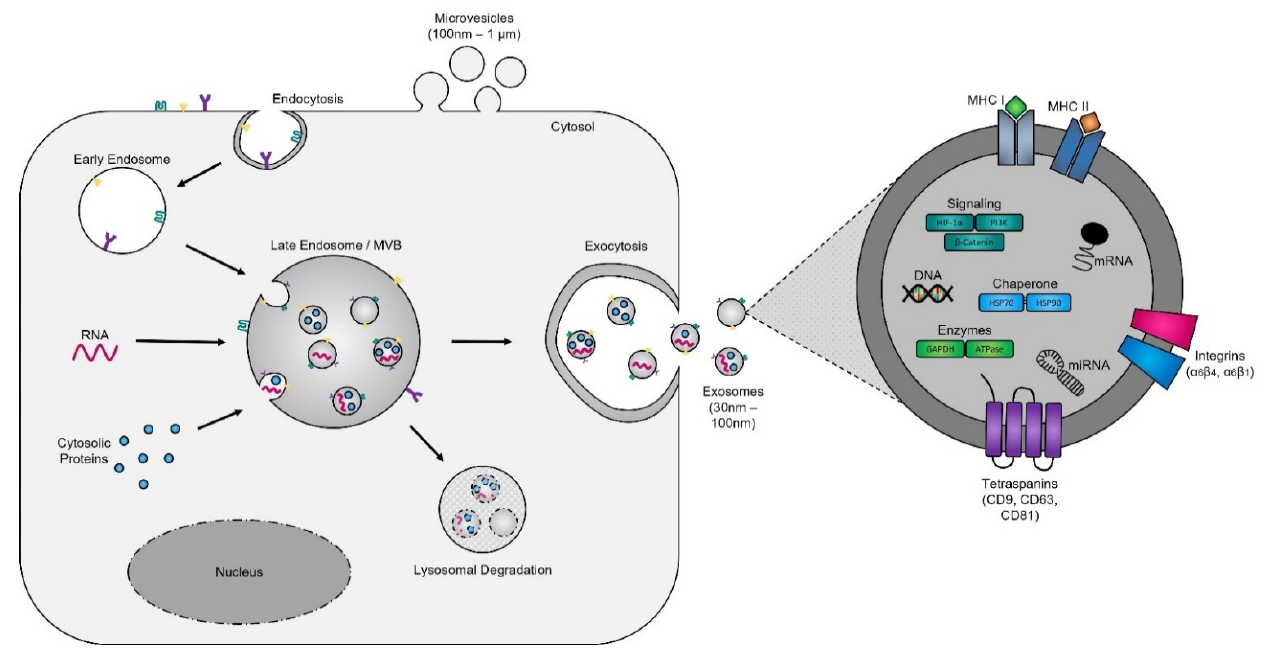
Figure 3. Exosome biogenesis. Exosomes originate from multivesicular bodies (MVBs) (also referred to as late endosomes). The inward budding of the late endosomal membrane around selectively packaged cargo results in the formation of exosomes. The selective packaging of proteins (e.g., tetraspanins, cytoplasmic proteins, and enzymes), nucleic acids (e.g., DNA, RNA, and miRNAs), and lipids (e.g., cholesterol) into exosomes is cell-type dependent and reflects the metabolic status of originating cells. Fusion of MVBs with either lysosomes or the plasma membrane results in either degradation or the release of exosomes into the extracellular matrix, respectively.